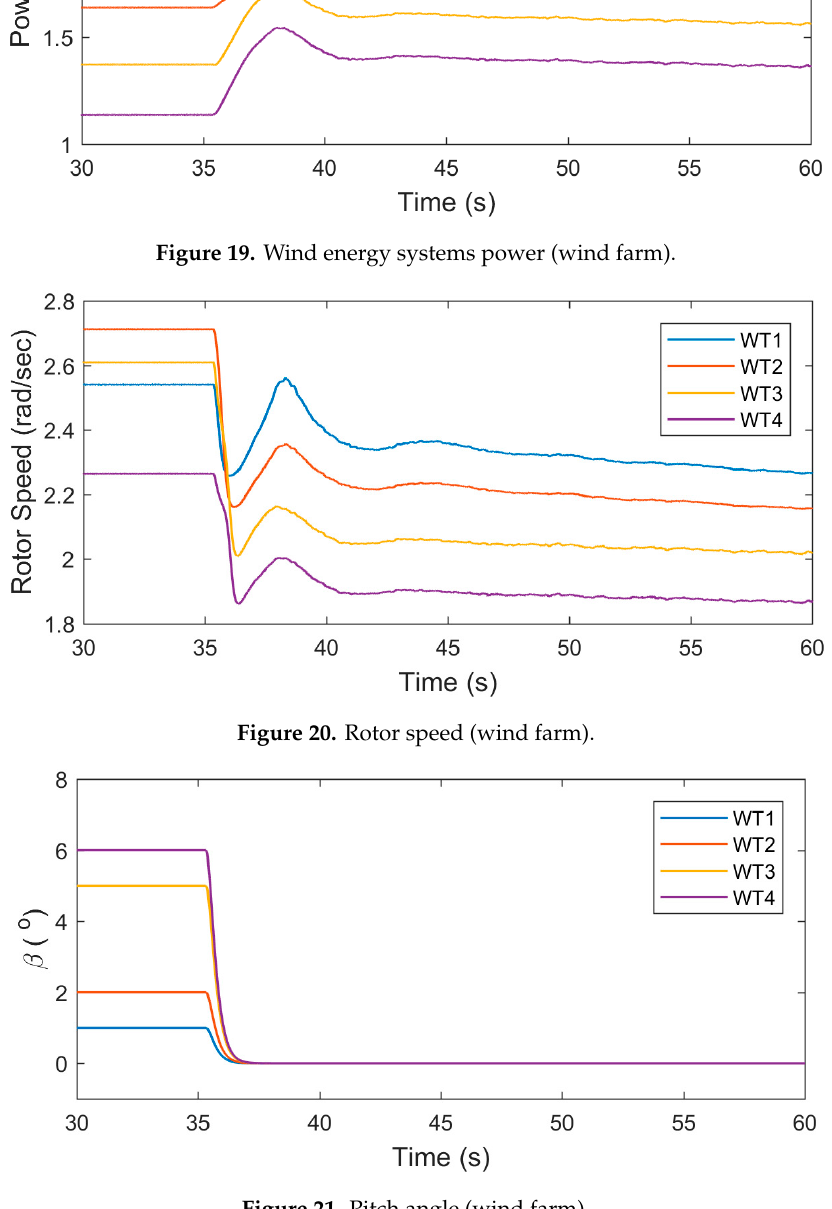
Figure 21. Pitch angle (wind farm).